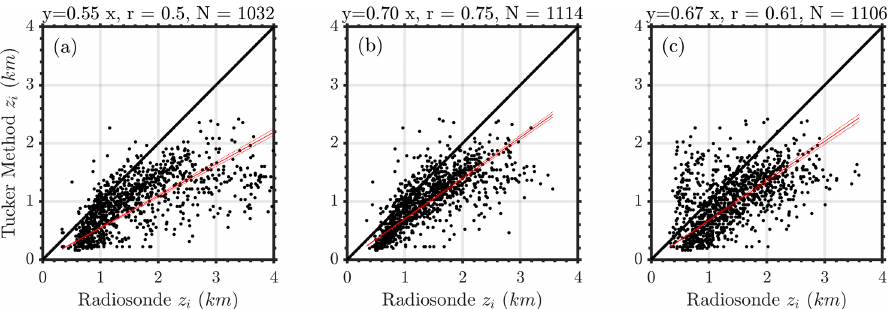
Figure 3. Comparisons between Tucker method and three different z i estimates from radiosondes. (a) Heffter (1980), (b) Liu and Liang (2010), and (c) bulk Richardson number method using a threshold of 0.5. The red line is the best fit with the fit y = mx shown above. r is the correlation coefficient, and N is the total number of radiosonde and Tucker method observations used in each scatter plot.